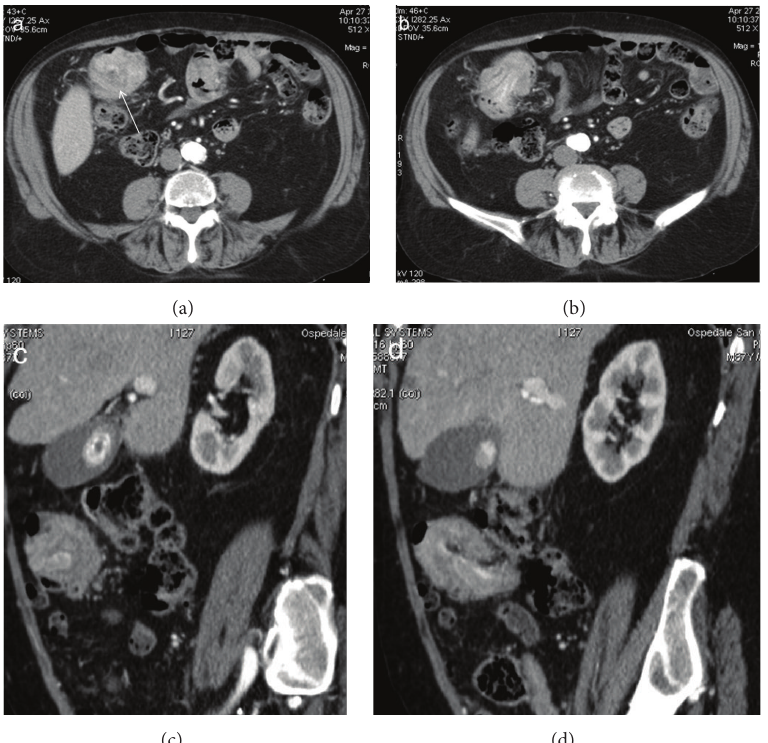
Figure 14: Enterocolonic (ileocaecocolonic) intussusception caused by a polyp. Axial CT images (a, b) demonstrate a soft-tissue density round mass with thin eccentric hypodensity (arrow). Oblique CT reformatting (c, d) clearly shows the enhancement of the lead mass, which facilitates its